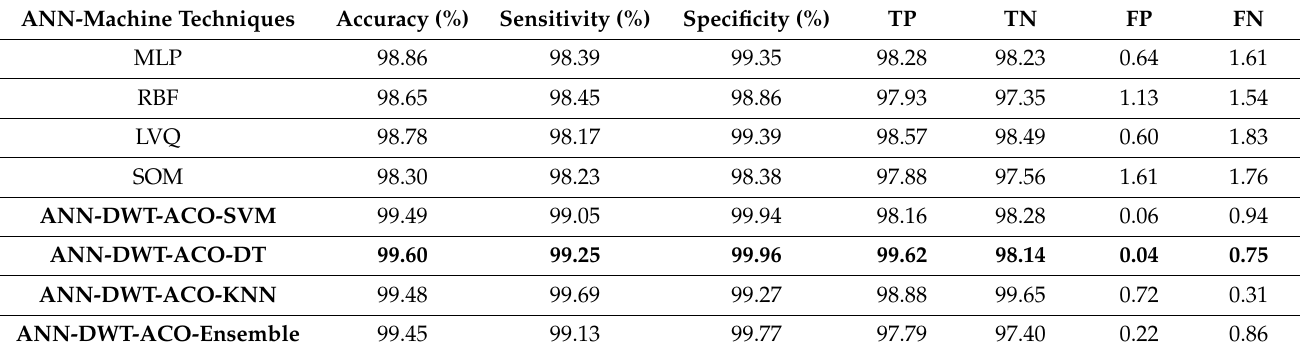
Figure 9. Accuracy of the classification for the proposed classifier. Table 3. The proposed method’s accuracy, sensitivity, and specificity.